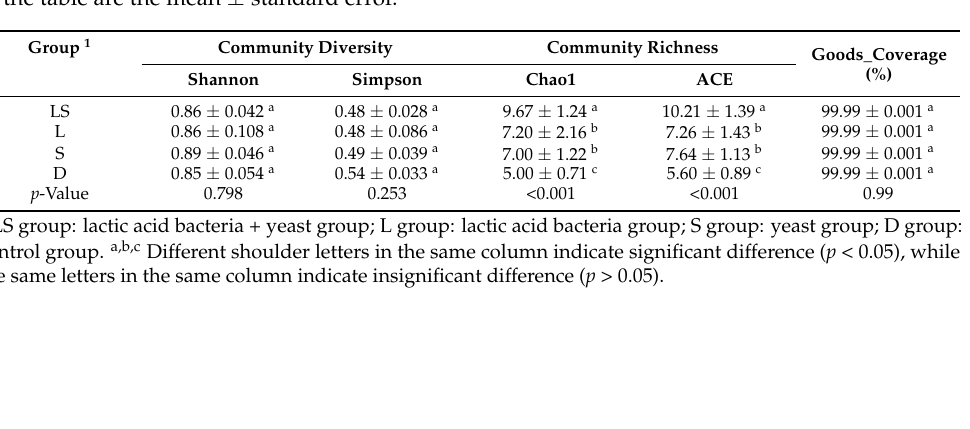
Table 3. Alpha diversity indices of newborn cattle in groups fed different compound probiotics. Data in the table are the mean ± standard